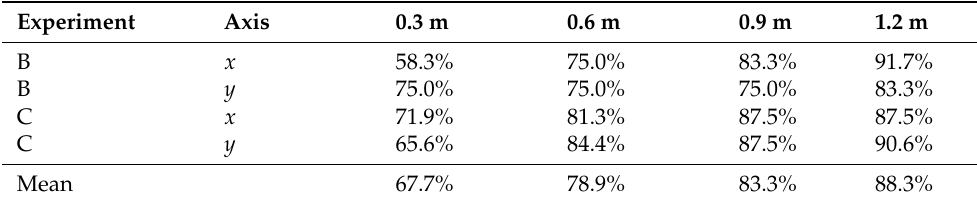
Table 11. Estimation accuracies within grids up to the third